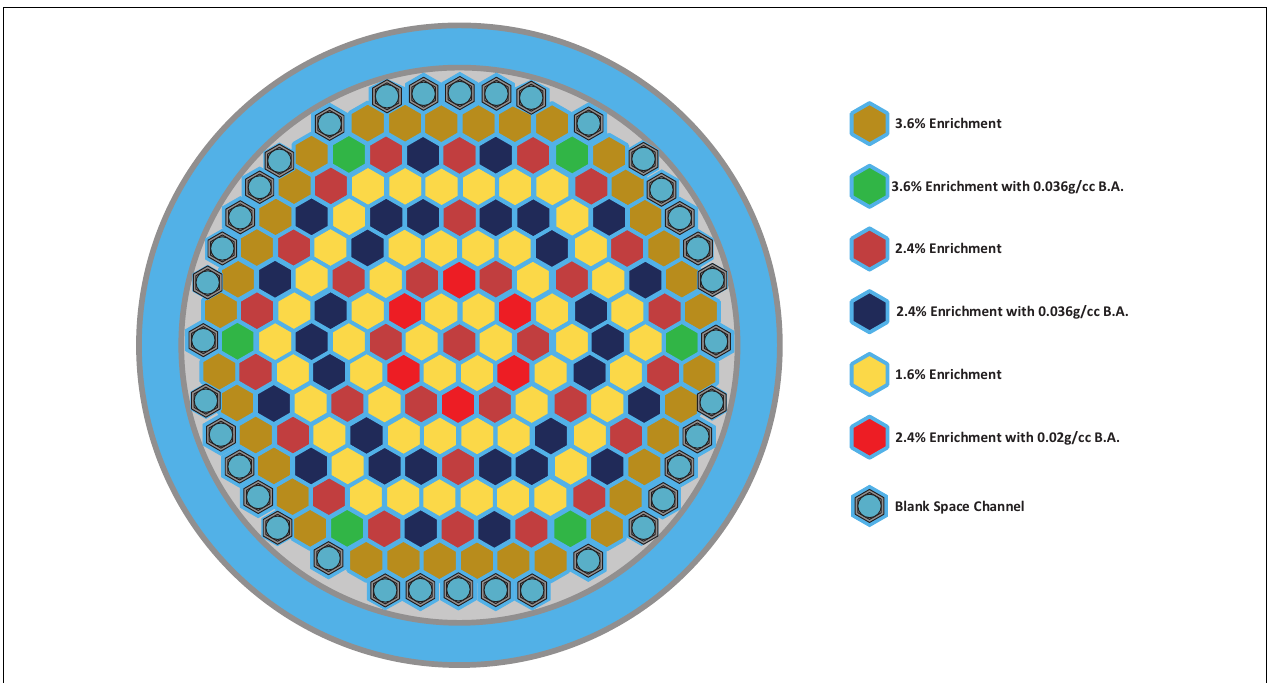
FIGURE 3 | VVER1000/446 core fuel enrichment placement.